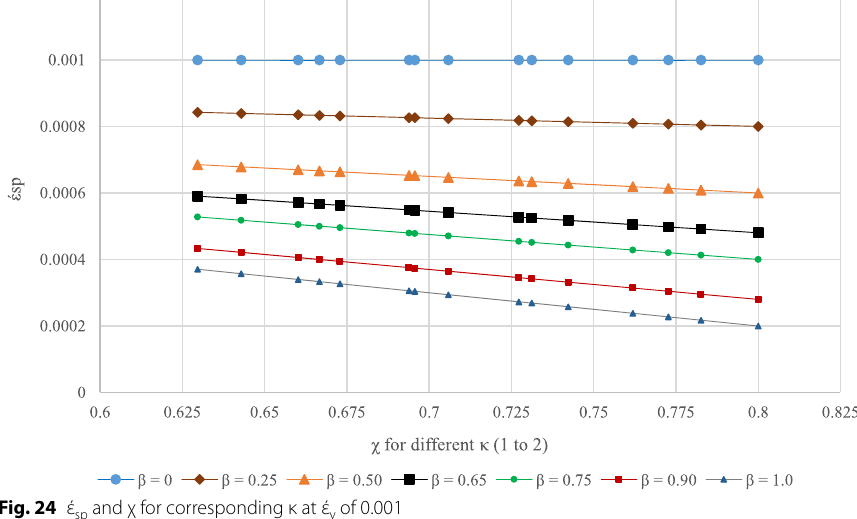
Fig. 24 έ sp and χ for corresponding κ at έ y of 0.001